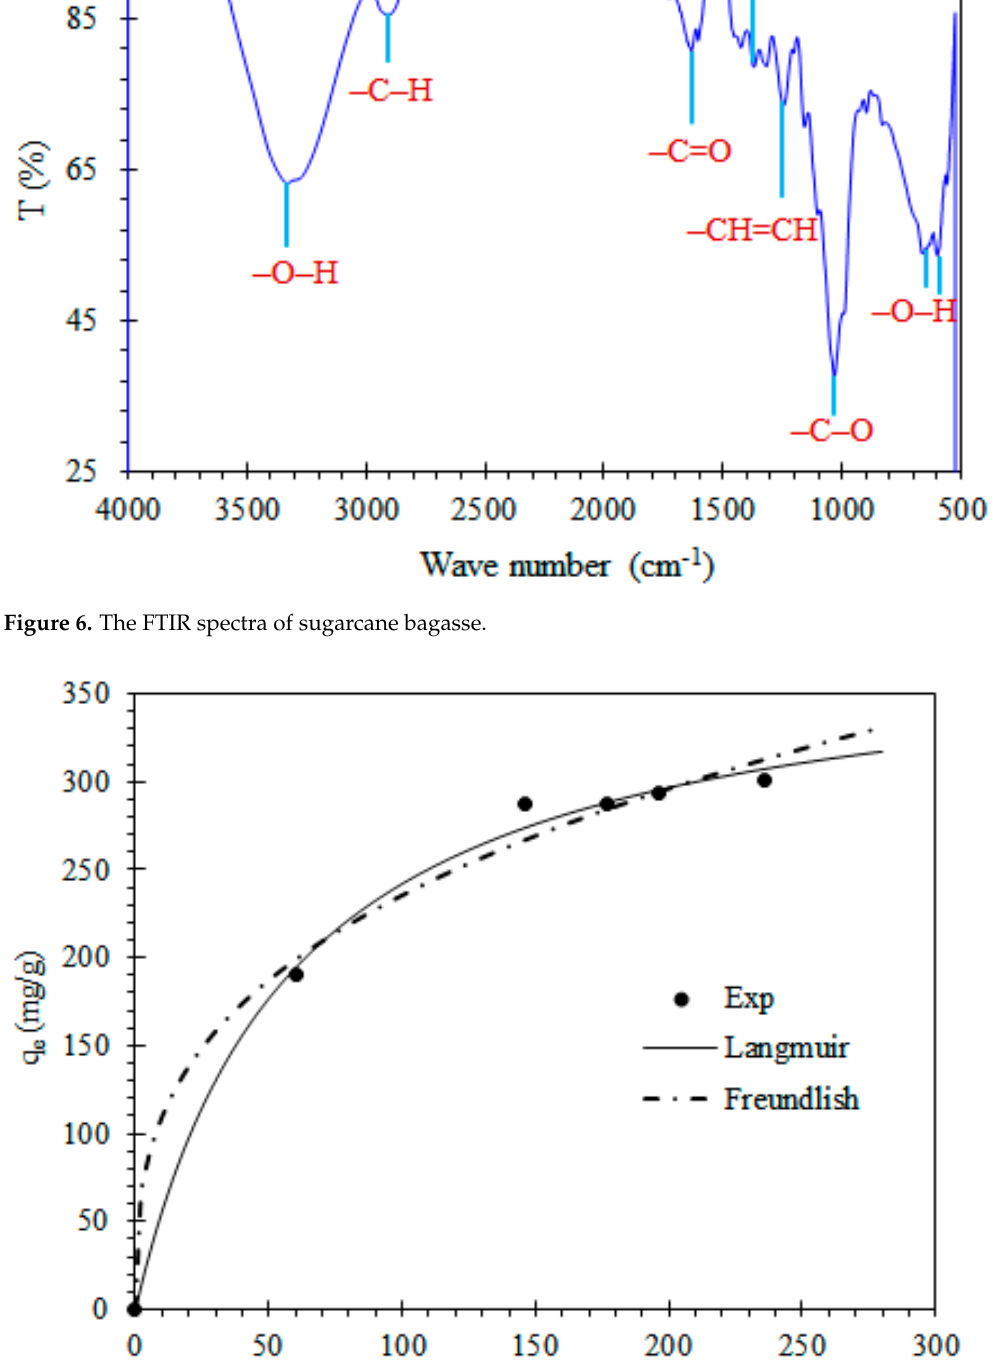
Table 5. Parameters and error function data for sorption isotherm models obtained from non-linear regression forms.